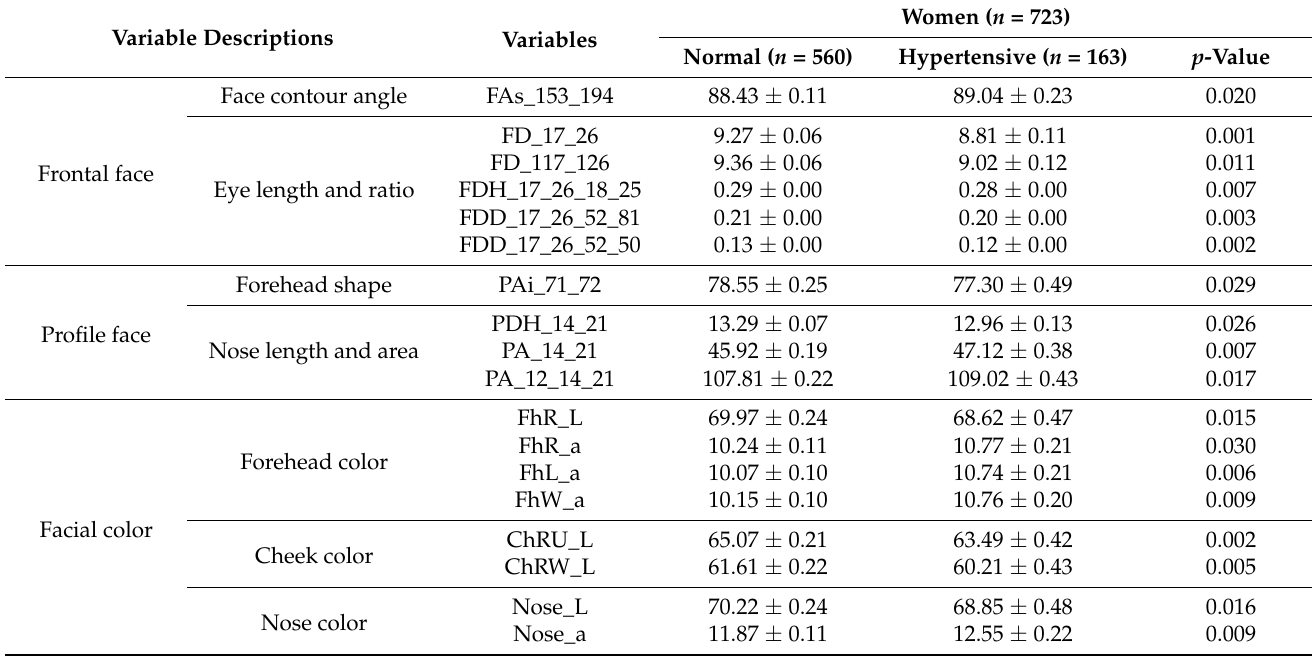
Table 5. Differences in facial characteristic variables in women. Table 3. General characteristics of subjects.